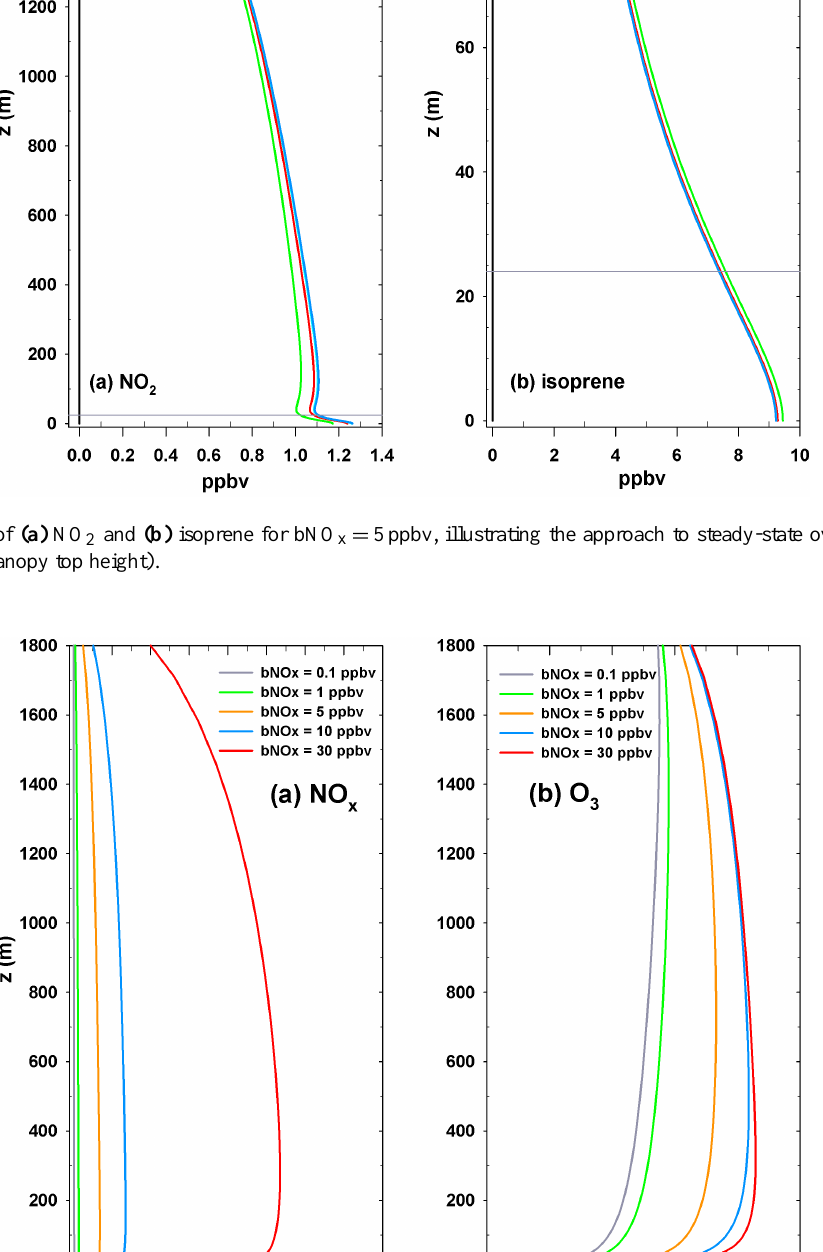
Atmos. Chem. Phys., 13, 693–715, 2013